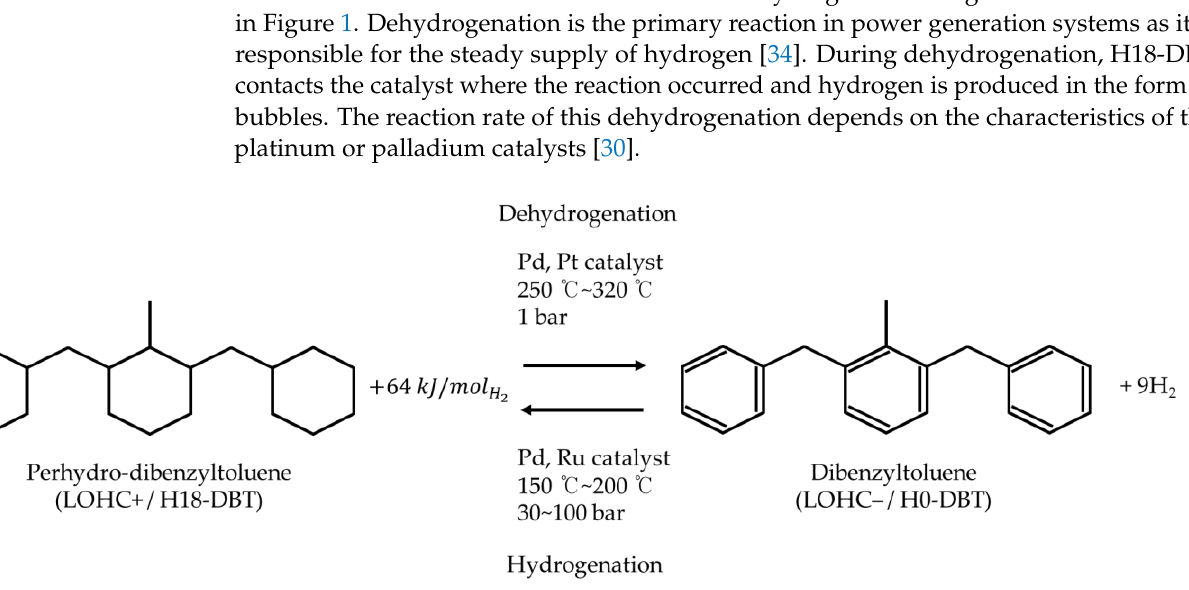
Figure 1. Schematic diagram of dehydrogenation and hydrogenation of dibenzyltoluene/perhydro-dibenzyltoluene [34].